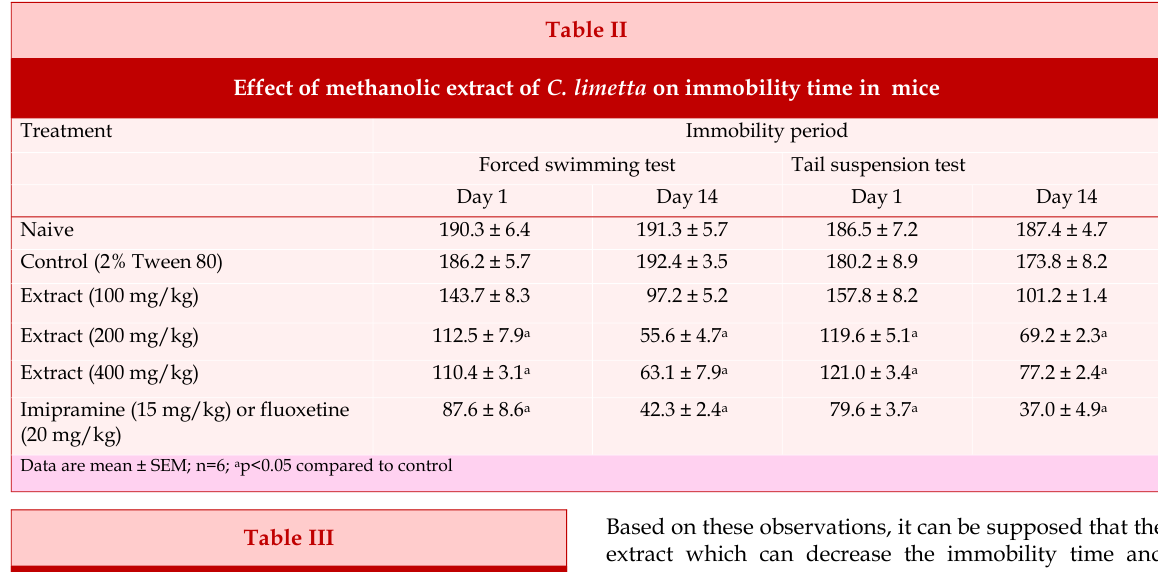
Effect of methanolic leaves extract of C.